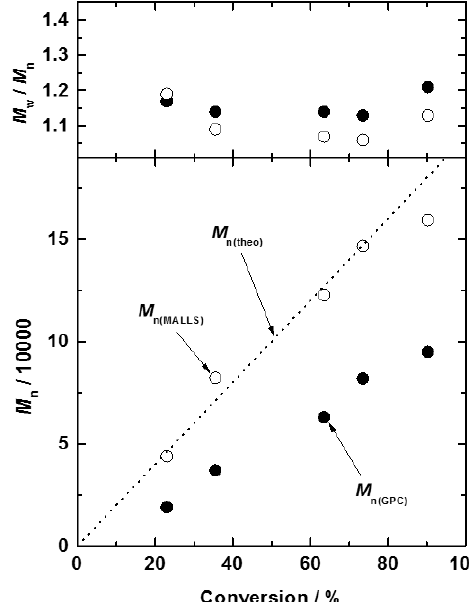
Figure 3. Evolution of number-average molecular weight ( M n ) and polydispersity index ( M w / M n ) of poly(DEMM-TFSI) estimated from GPC calibrated by standard poly(ethyleneoxide)s (filled circle) and by MALLS (open circle), as a function of monomer conversion for the solution polymerization of N , N -diethyl -N -(2-methacryloylethyl)- N -methylammonium bis(trifluoromethylsulfonyl)imide (DEMM-TFSI, 70 wt %) in acetonitrile at 70 °C: [DEMM-TFSI] 0 /[ethyl-2-bromoisobutyrate] 0 /[Cu(I)Cl] 0 /[Cu(II)Cl 2 ] 0 /[2,2 ′ -bipyridine] 0 = 1000/1/4.5/0.5/10. The broken line represents the theoretical molecular weight ( M n(theo) ) values calculated with the initial molar ratio of DEMM-TFSI and the monomer conversion.